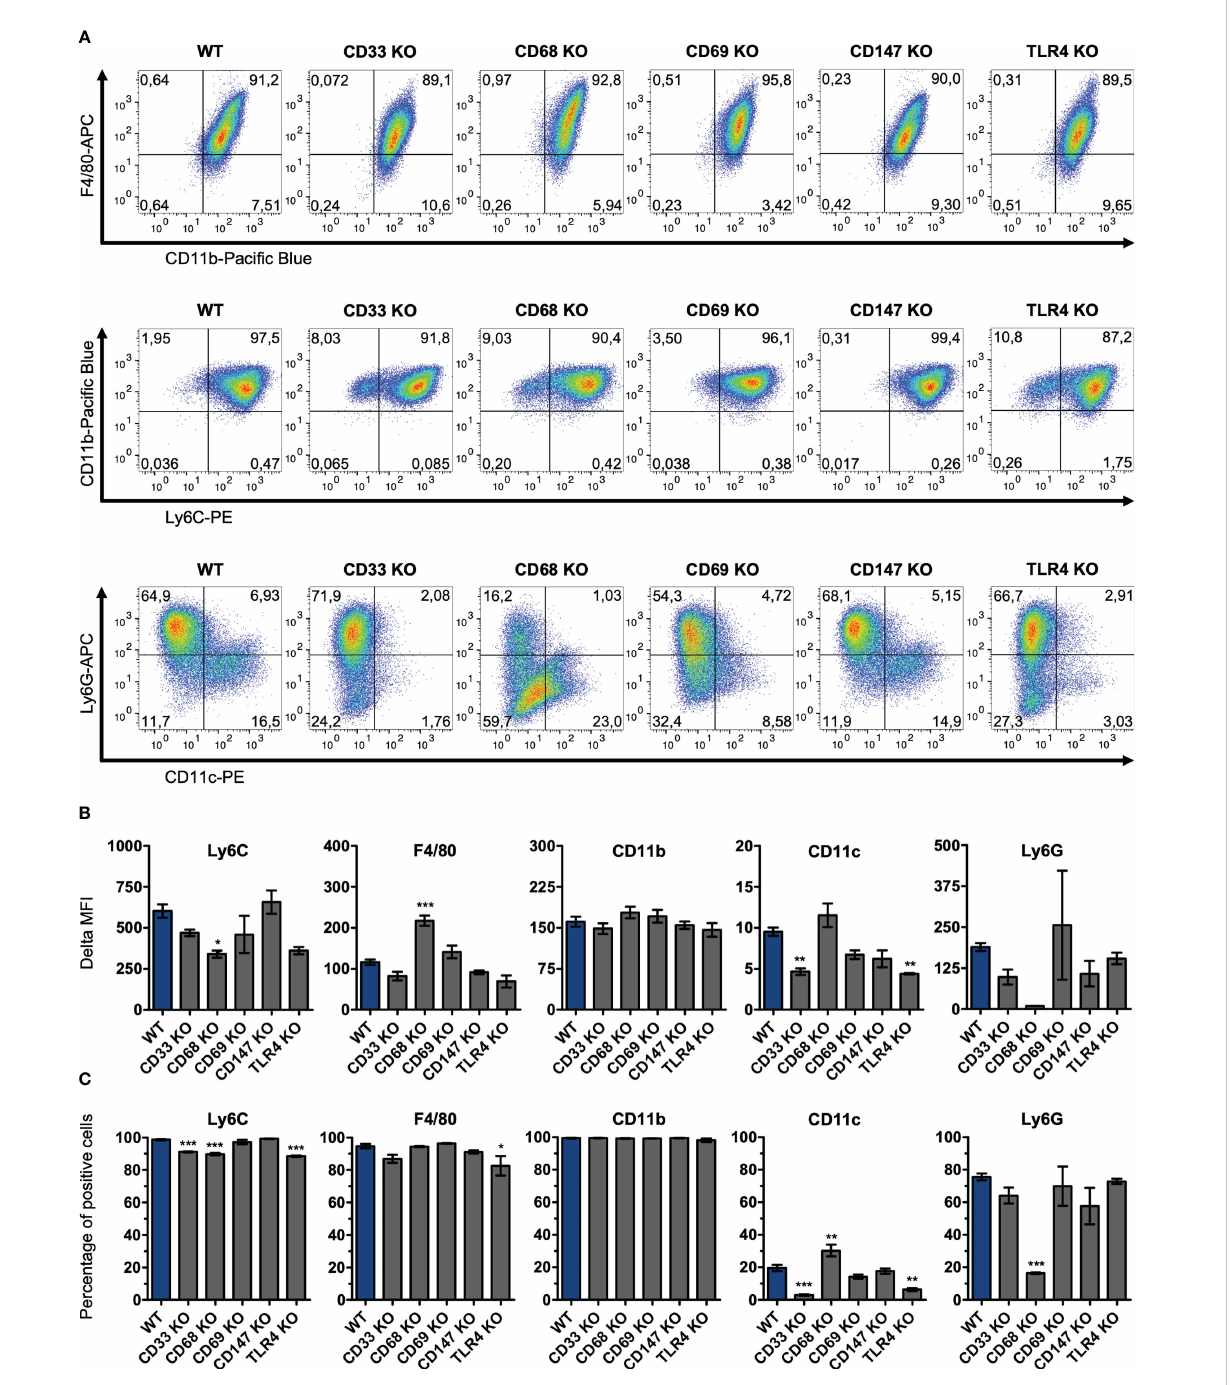
FIGURE 2 Surface expression levels of differentiation markers on knockout ER-Hoxb8 macrophages. CD33, CD68, CD69, CD147 and TLR4 knockout ER- Hoxb8 precursor cells, as well as WT ER-Hoxb8 precursor cells were differentiated into macrophages and subsequently analyzed by fl ow cytometry (n = 3) regarding their expression of Ly6C, F4/80, CD11b, CD11c and Ly6G. Representative pseudocolor plots (A) , Delta MFI values (B) and percentages of marker positive cells (C) are shown for each cell line. Delta MFI values are calculated as differences of geometric mean fl uorescence intensities. Values are the means ± SEM. *p < 0.05, **p < 0.01, ***p < 0.001, by one-way ANOVA and Dunnett's test in comparison to